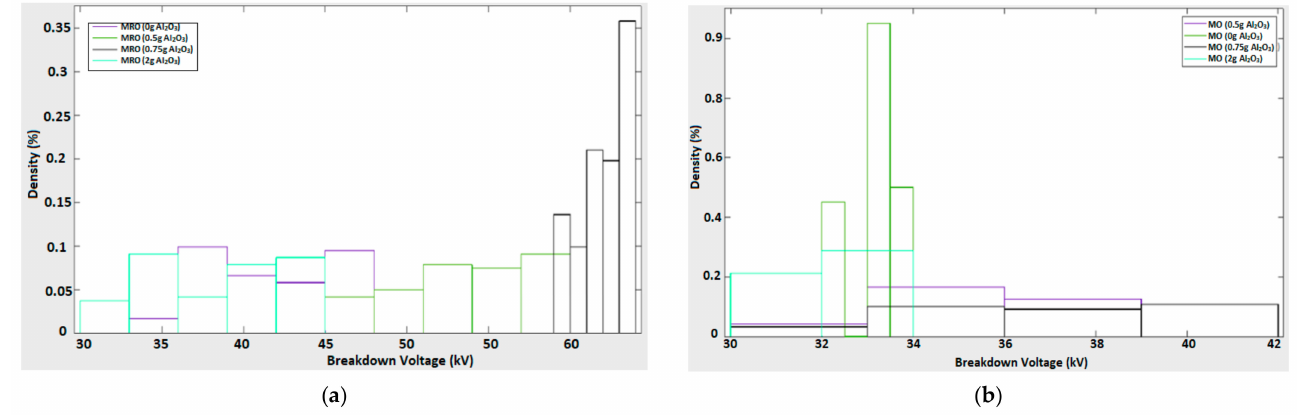
Figure 7. % Density function of the breakdown voltage in different concentration of the Al2O3, ( a ) MRO, ( b ) MO.